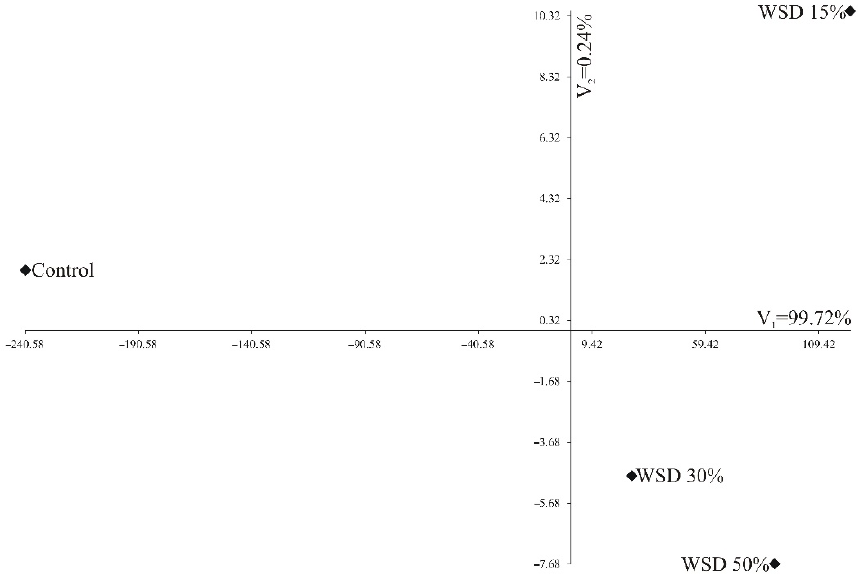
Figure 1. The distribution of water saturation deficit (WSD) variants in the system of the first two canonical variables. A canonical variate analysis (CVA) of the variability of the nine traits of four WSDs in terms of the first two canonical variates was performed.